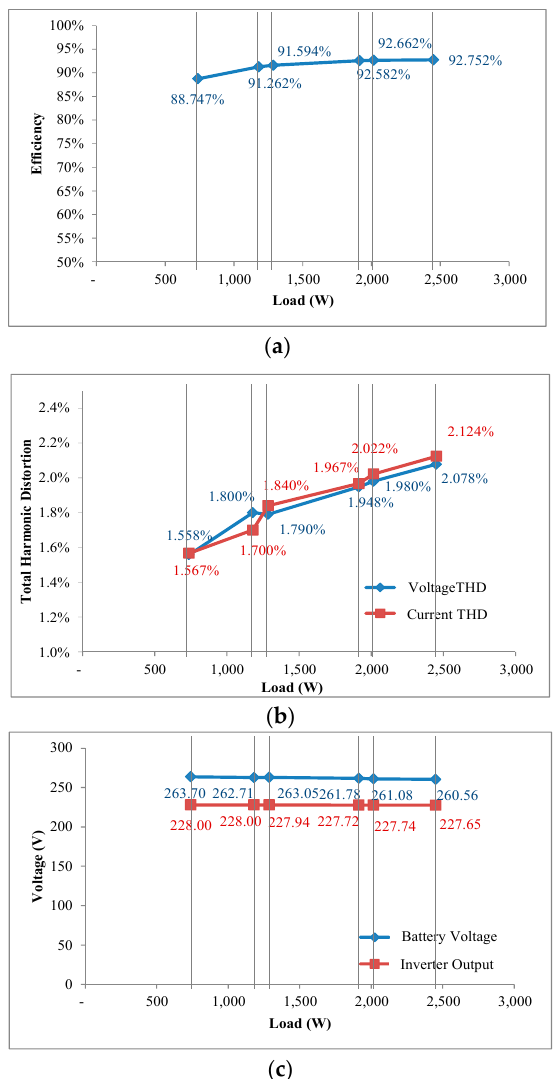
Figure 8. Inverter evaluation: ( a ) Efficiency vs. load, ( b ) voltage and current THD vs. load, and ( c ) battery and inverter voltage vs. load.